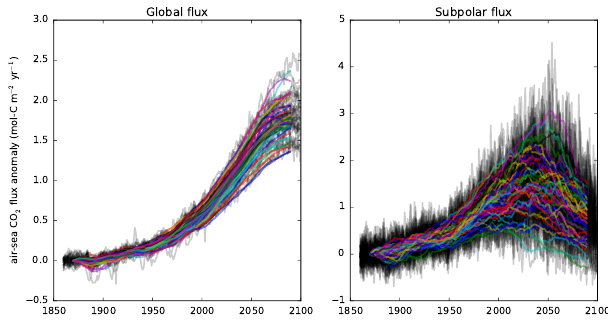
Figure 1. Left: globally averaged air–sea CO 2 flux, and right: North Atlantic subpolar region averaged air–sea CO 2 flux. Black lines rep- resent annually averaged time series from all ESPPE members, and coloured lines represent those time series after application of a 20- year running